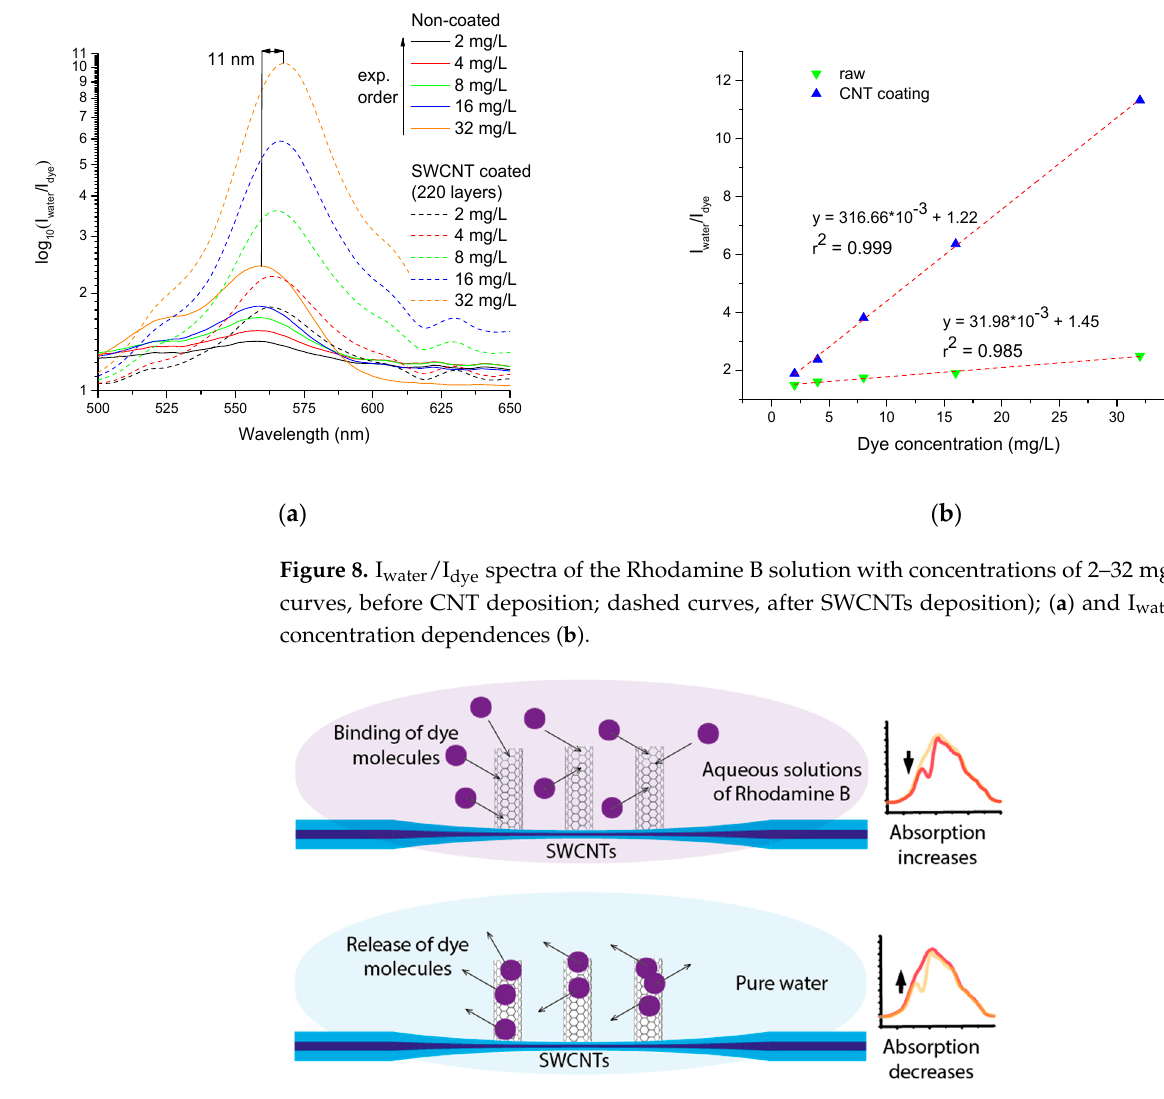
Figure 9. The mechanism of Rhodamine B molecules’ interaction with SWCNTs.